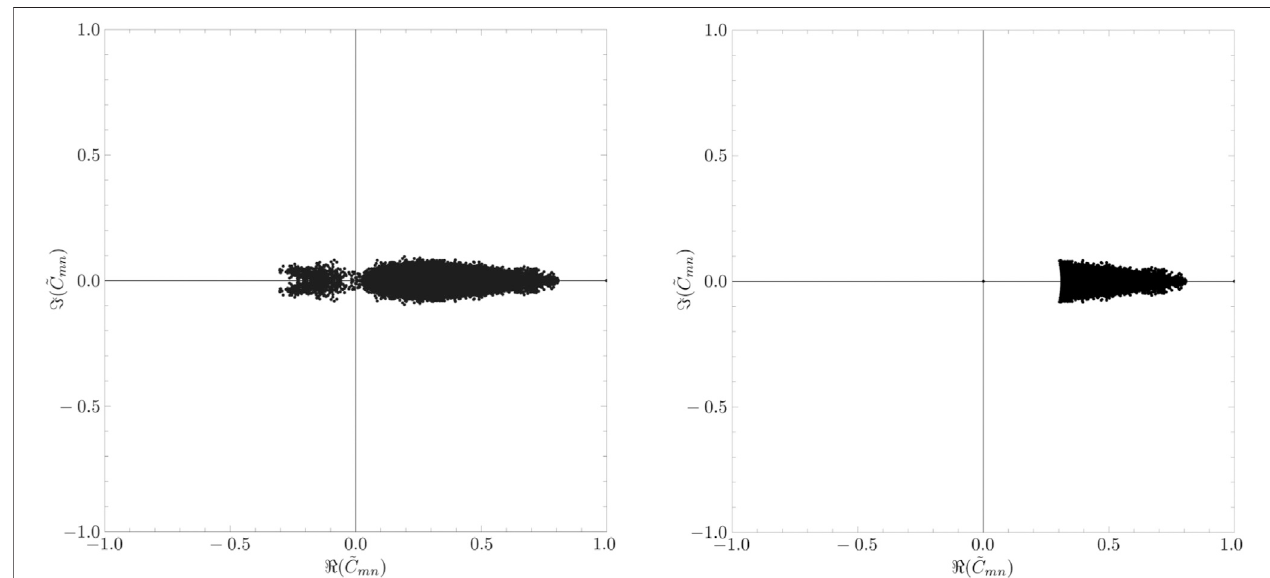
FIGURE 11 | (Left) Distribution of the components of the meaningful part of the complex correlation matrix. (Right) Distribution of the components of the constrained meaningful part of the complex correlation matrix.